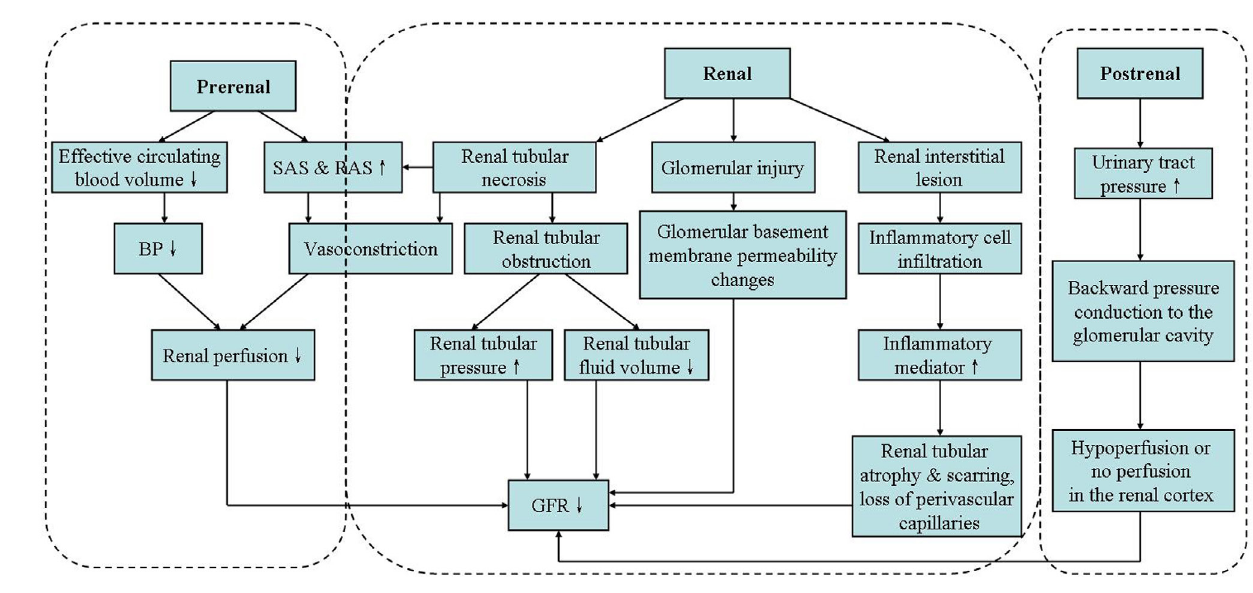
Fig. 1 – A conceptual model of the pathophysiology of acute kidney injury after cardiac surgery. BP=blood pressure; GFR=glomerular filtration rate; RAS=renin-angiotensin system; SAS=sympathetic-adrenomedullary